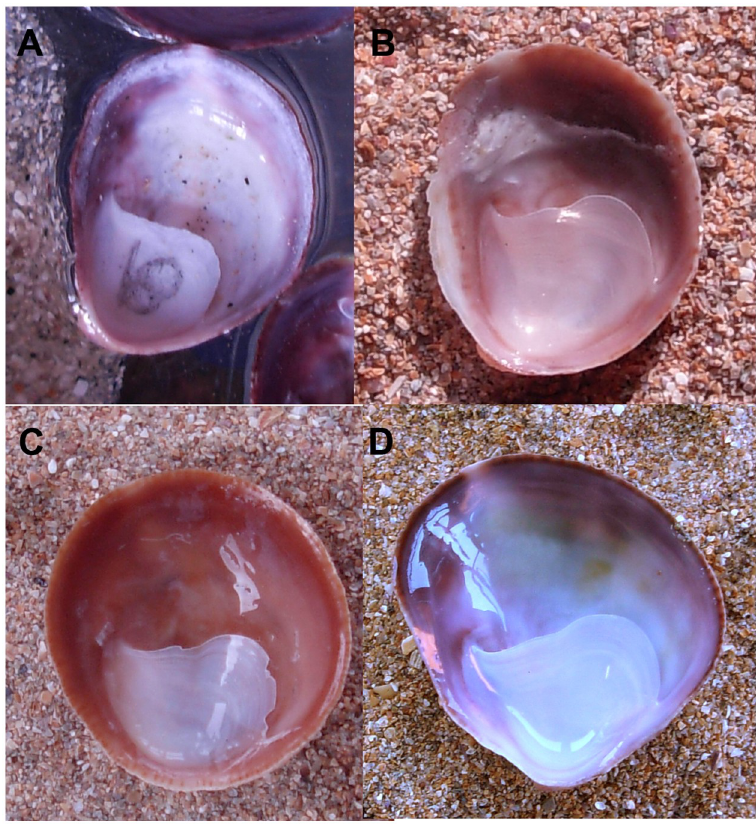
Fig 4. Shell morphotypes of introduced C . dilatata . Apertural view of an individual exhibiting a shell morphotype of cluster 3 (A), cluster 2 (B), cluster 1 (C) and cluster 4 (D). Scale bars: A–D = 1 cm.